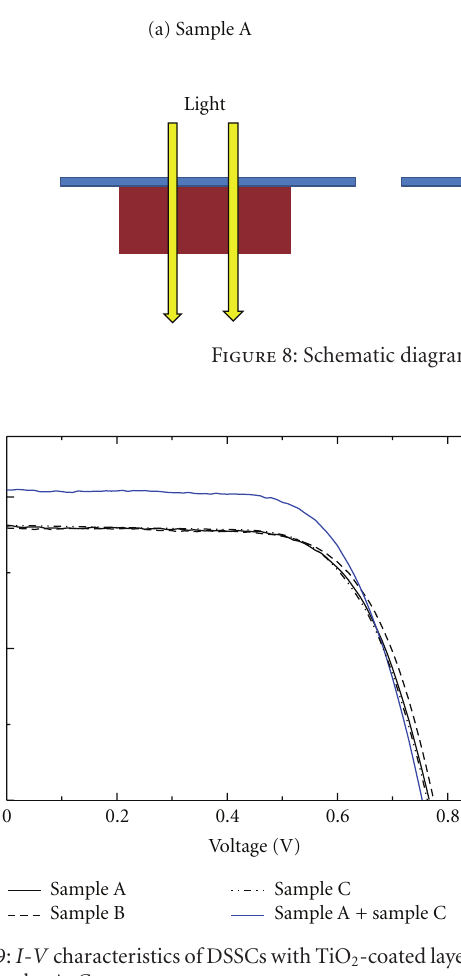
Figure 10: Photo action spectra of dye-sensitized solar cells, which were normalized to the peak of sample A +